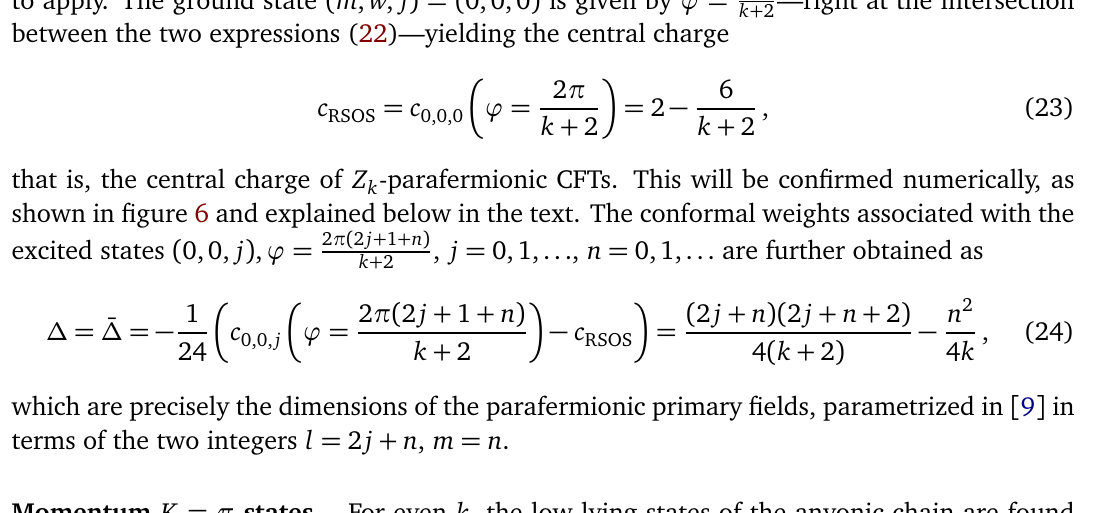
Figure 5: Discrete states structure of the Izergin-Korepin vertex model as a function of the boundary twist ϕ . We plotted on the vertical axis the rescaled energies of the levels E the sector of magnetization m = 0), related to the central charges (22) by E (therefore related to the conformal weights). The shaded area represents the continuum of states. Normalizable (resp. non-normalizable) discrete states present in (resp. absent from) the physical spectrum are represented by solid (resp. dashed)